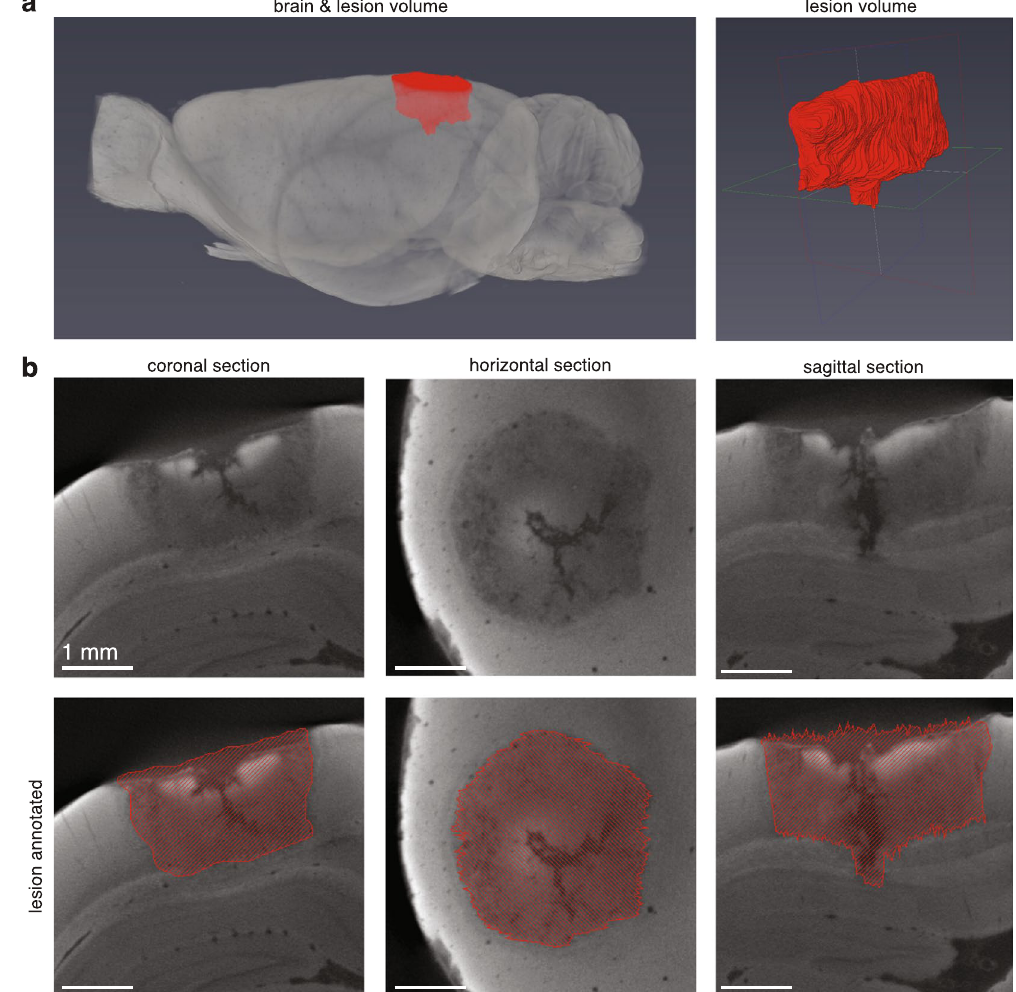
Figure 3. Visual cortex lesion characterization using micro-CT. ( a ) 3D visualization of rat brain lesioned in visual cortex with quinolinic acid. Left panel shows lesion volume in context of brain (brain made slightly transparent to allow visual access to lesion). Right panel shows isolated lesion volume. ( b ) 2D slices of lesion in the coronal, horizontal, and sagittal planes (12.8 μ m voxels). Top three panels show the unsegmented sections; bottom three panels show sections with overlaid lesion annotation. This lesion was manually annotated in the coronal orientation every 2 slices. The volume was then created through